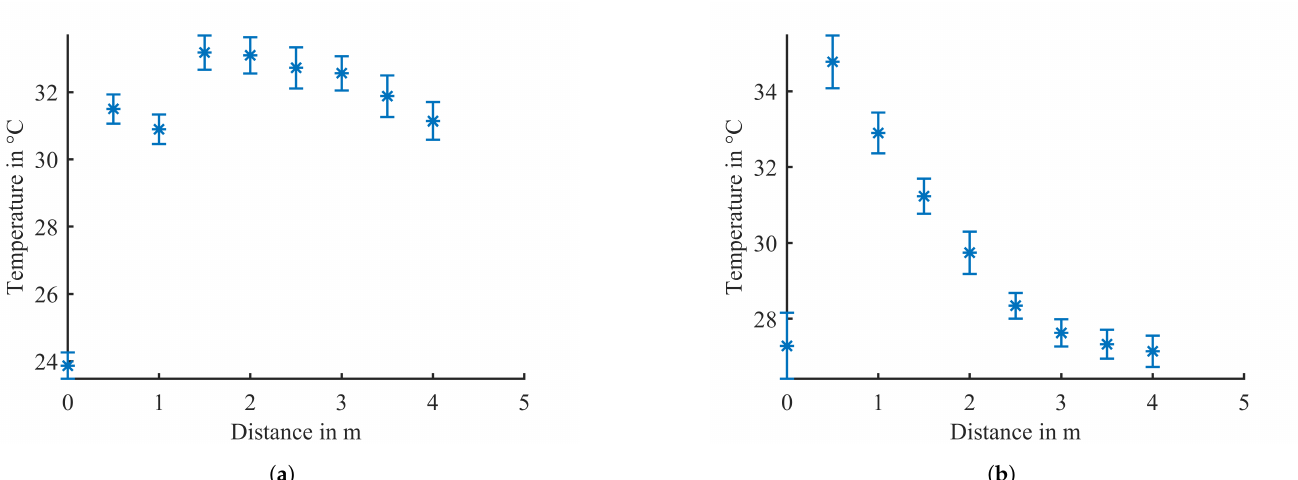
Figure 9. 100 Measurements with human-being in distances from 0.5 m to 4 m for both sensors, the TeraRanger Evo Thermal 33 and 90. ( a ) Evo Thermal 33: 100 Measurements with human in distances from 0.5 m to 4 m; ( b ) Evo Thermal 90: 100 Measurements with human in distances from 0.5 m to 4